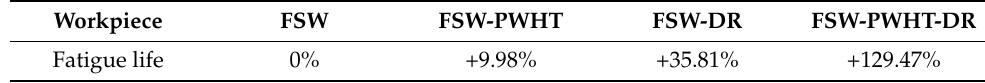
Table 10. Comparison of the fatigue life of the workpieces.